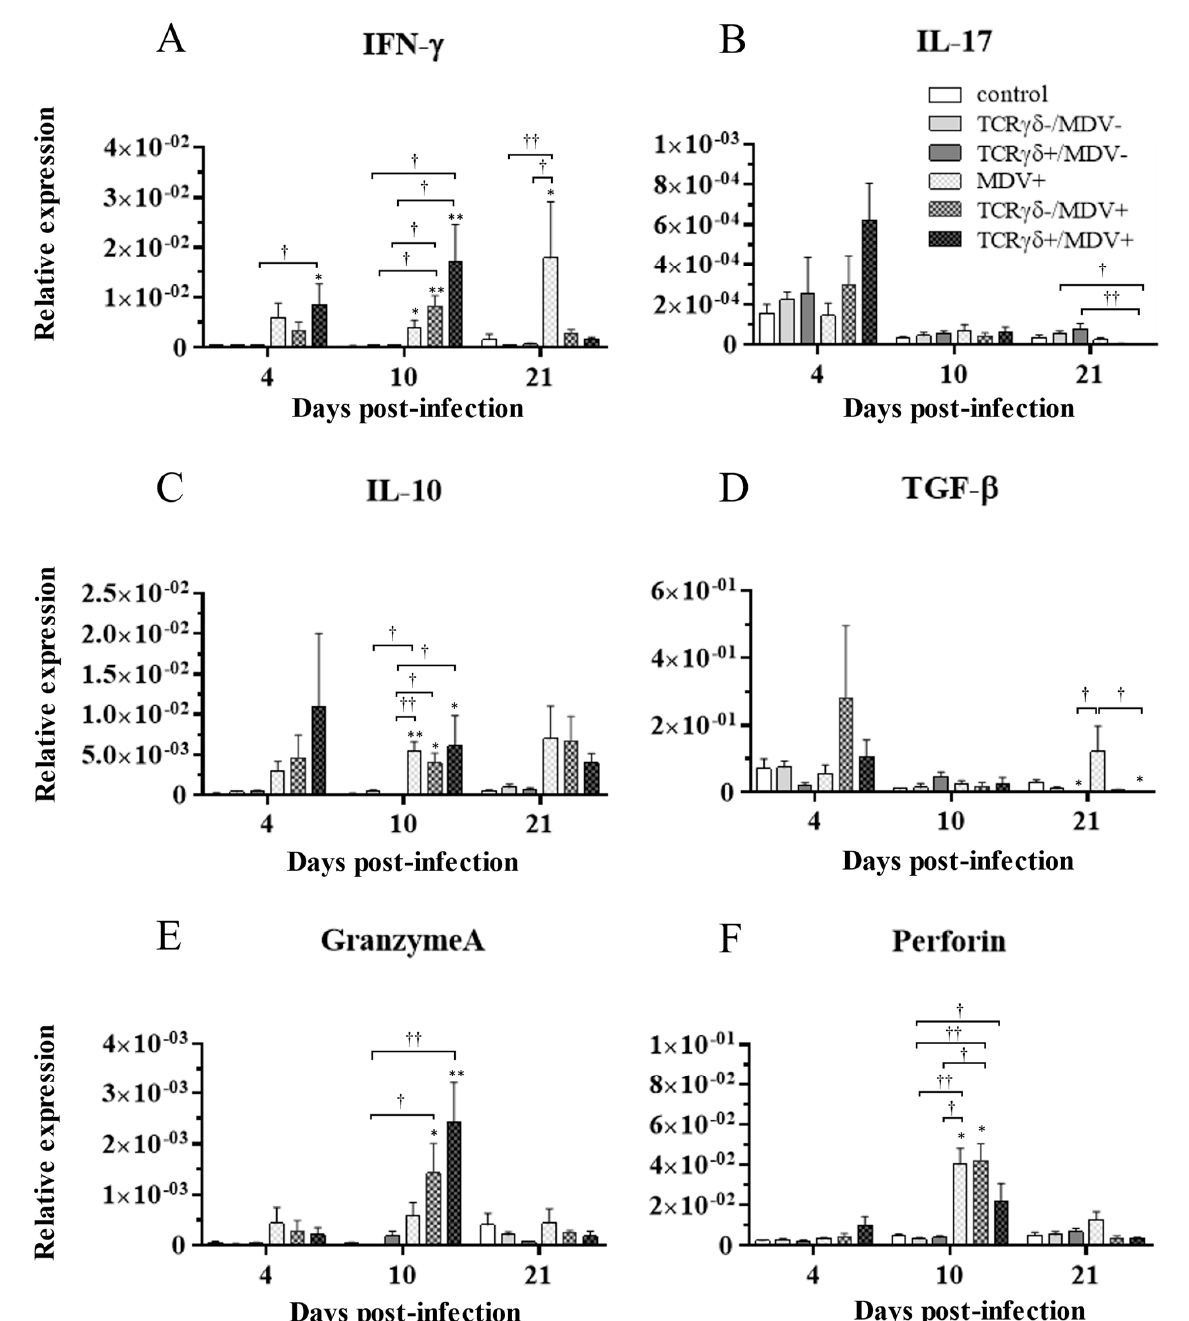
Figure 11. Cytokine, granzyme A, and perforin gene expression profiles in the PBMCs at 4, 10, and 21 dpi. Gene expression of IFN ‐γ ( A ), IL ‐ 17A ( B ), IL ‐ 10 ( C ), TGF ‐β ( D ), granzyme A ( E ), and perforin ( F ) in the PBMCs collected from the control, the unstimulated PBMCs control, the TCR γδ‐ /MDV ‐ , the TCR γδ +/MDV ‐ , the MDV+, the TCR γδ‐ /MDV+, and the TCR γδ +/MDV+ groups at 4, 10, and 21 dpi was determined by real ‐ time PCR. Target genes were normalized by β‐ actin. Data represent the mean of 5 biological replicates ± SE in each group at each time point. Significant differences are indicated by *: p < 0.05 (vs. control), **: p < 0.01 (vs. control), †: p < 0.05, and ††: p < 0.01.